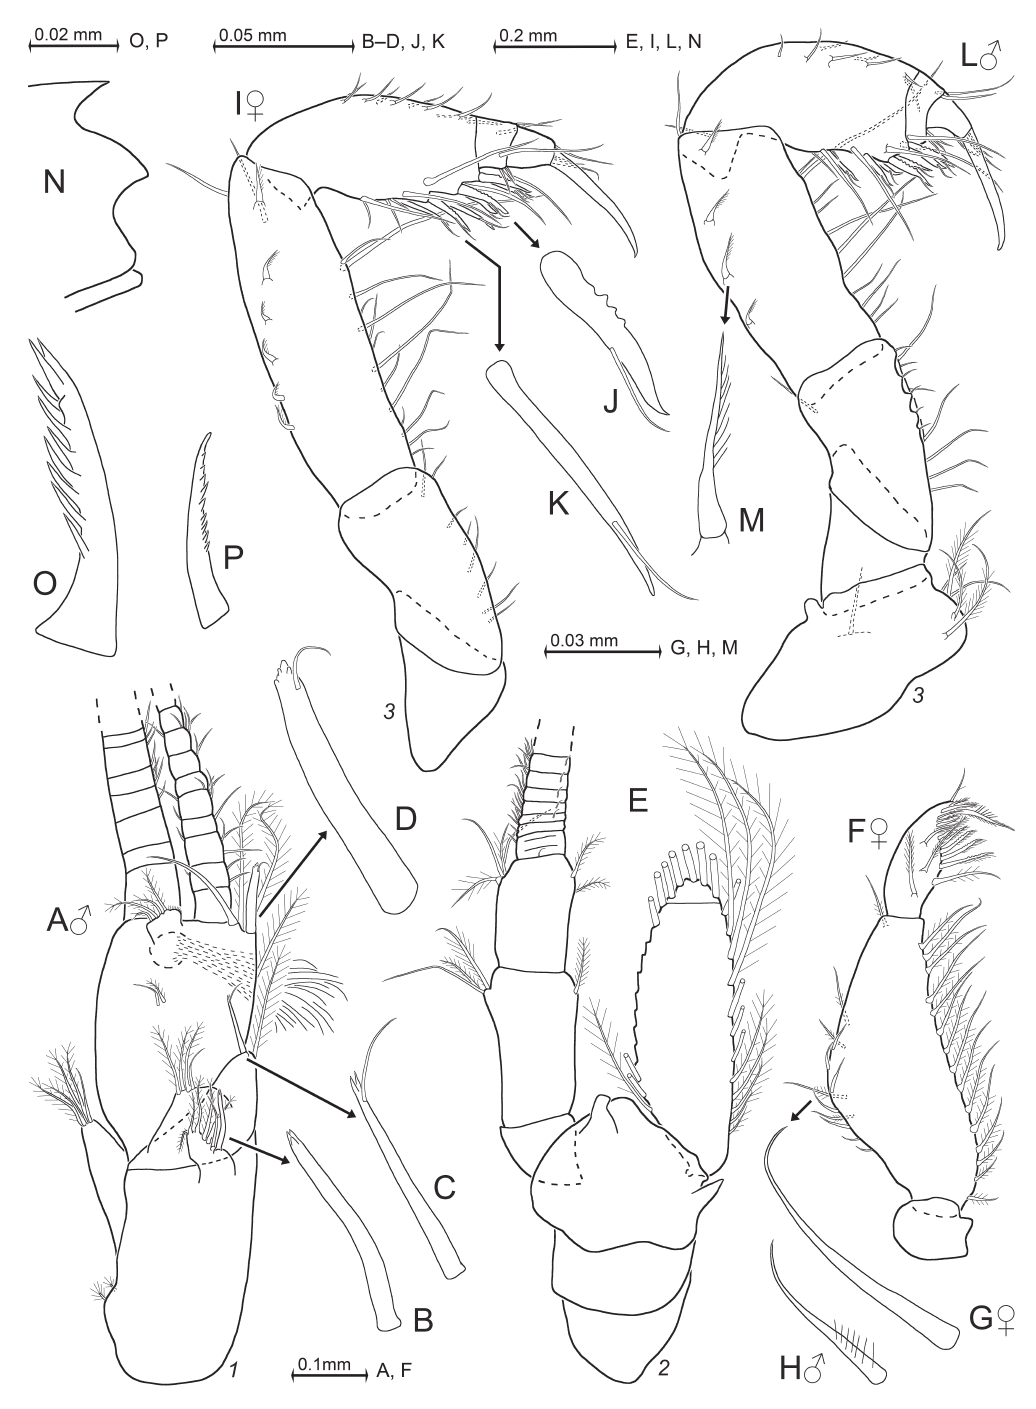
Fig. 10. Heteromysis waikikensis sp. nov., holotype, ♂ with body length 3.9 mm (N: NHMW 26965), paratypes, ♂ 4.2 mm (A–E, L–M, O–P: NHMW 26967 ) and ♀ 4.2 mm (F–K: NHMW 26966). A . Male antennula, dorsal. B–D . Details of male antennula (A) showing modified spines. E . Antenna with antennal gland, dorsal. F . Palp of left mandible, caudal. G–H . Setae from outer margin of median segment of mandibular palp in ♀ (G) versus ♂ (H). I . Left female thoracic endopod 3, rostral. J–K . Details of female endopod (I) 3 showing modified spines of carpus. L . Left male thoracic sympod and endopod 3, rostral. M . Detail of male endopod 3 (L) showing modified seta of merus. N . Scutellum paracaudale, lateral. O–P . Modified spines from dorsolateral infoldings (O) and lateralia (P) of